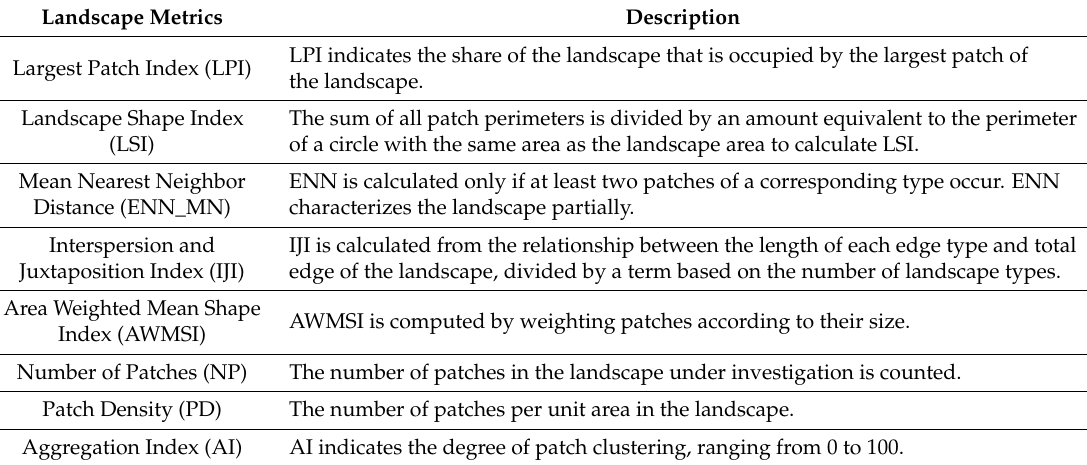
Table 4. The specific descriptions for eight landscape